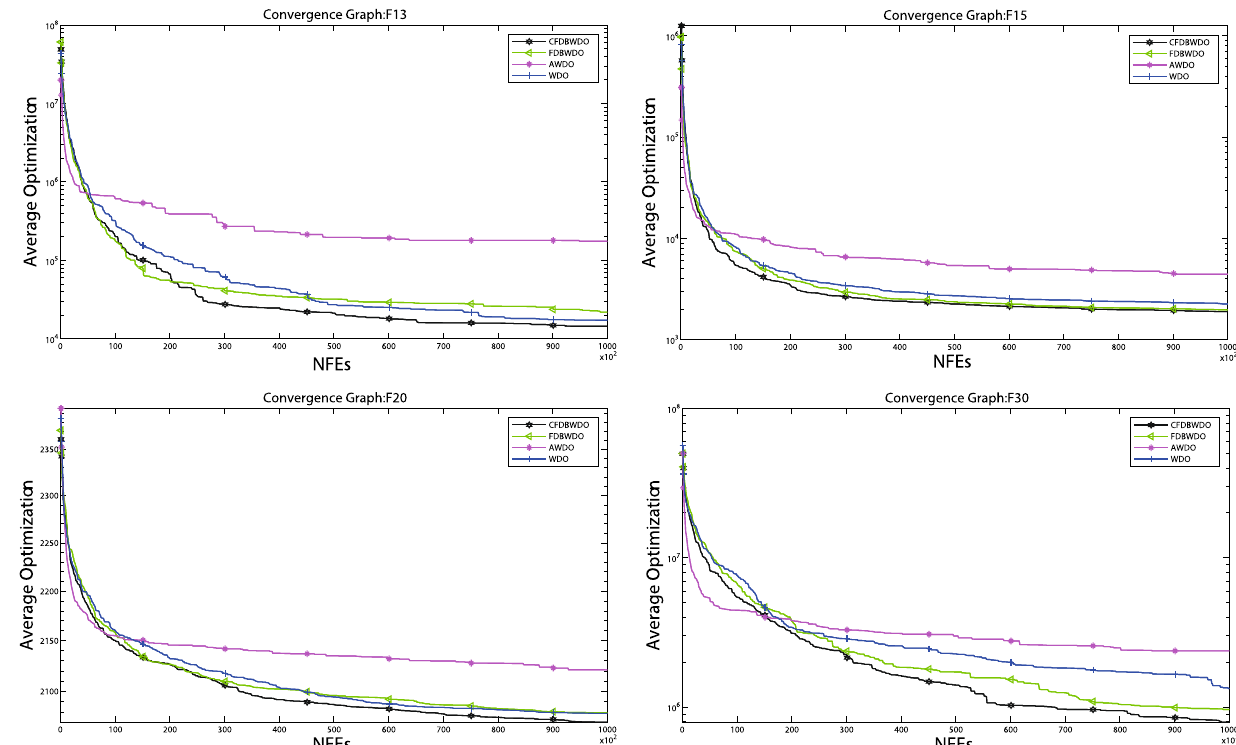
Fig. 4 Convergence graphs of four WDO variants on F13, F15, F20 and F30 with 10